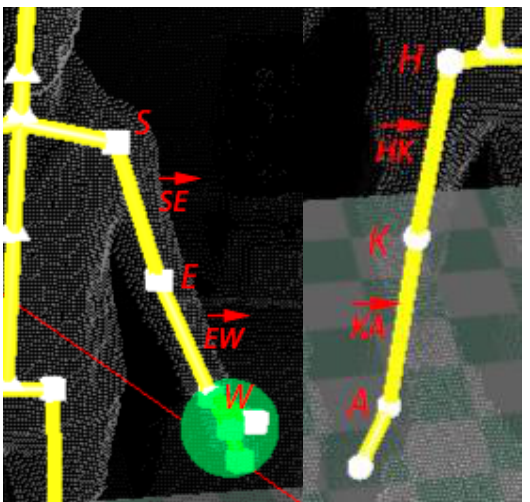
Figure 7. Joints and vectors involved in a calibration step for a shoulder exercise ( left ) and a knee exercise ( right ).